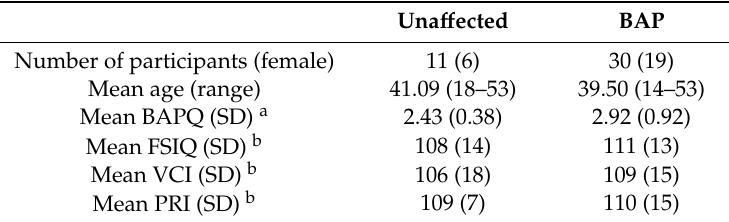
Table 6. Demographics of the small families sample.